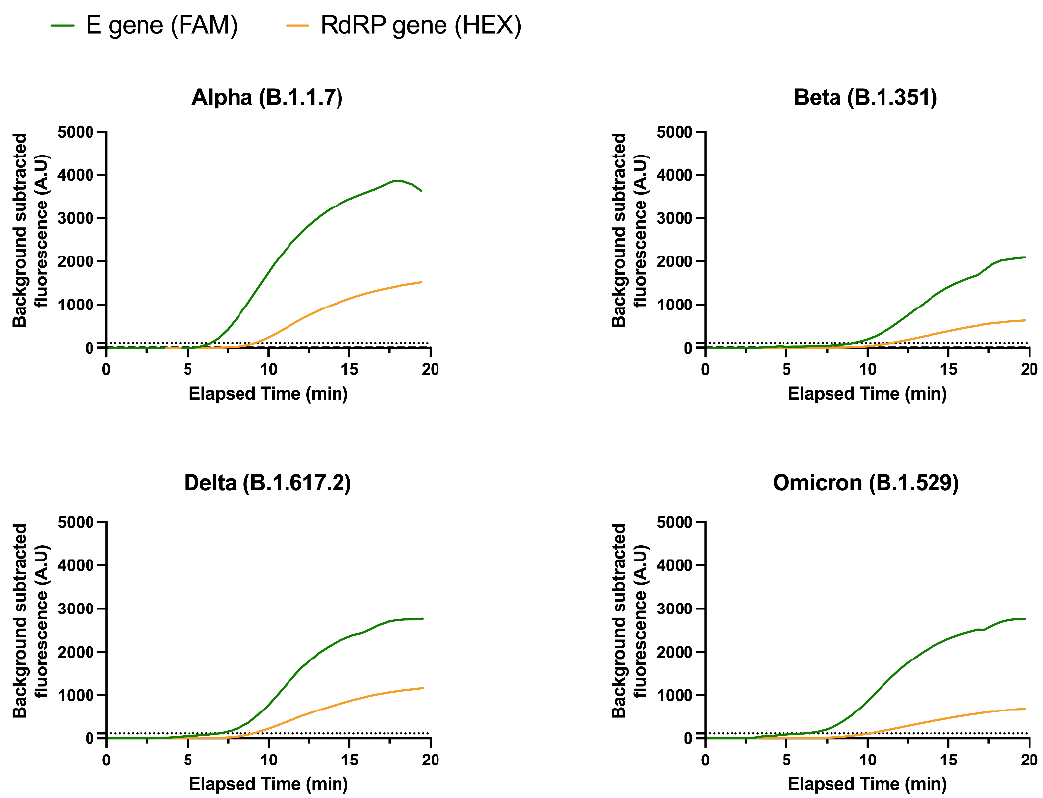
Figure 2. Detection of SARS-CoV-2 VOCs clinical samples by one-pot multi-gene RT-RPA real-time fluorescence assay. Detection of the four VOCs tested (Alpha, Beta, Delta, and Omicron) by both E and RdRP gene targets of the RT-RPA assay. Note: the Alpha sample is sample 8; the Beta sample is sample 55; the Delta sample is sample 70; the Omicron sample is sample 54.